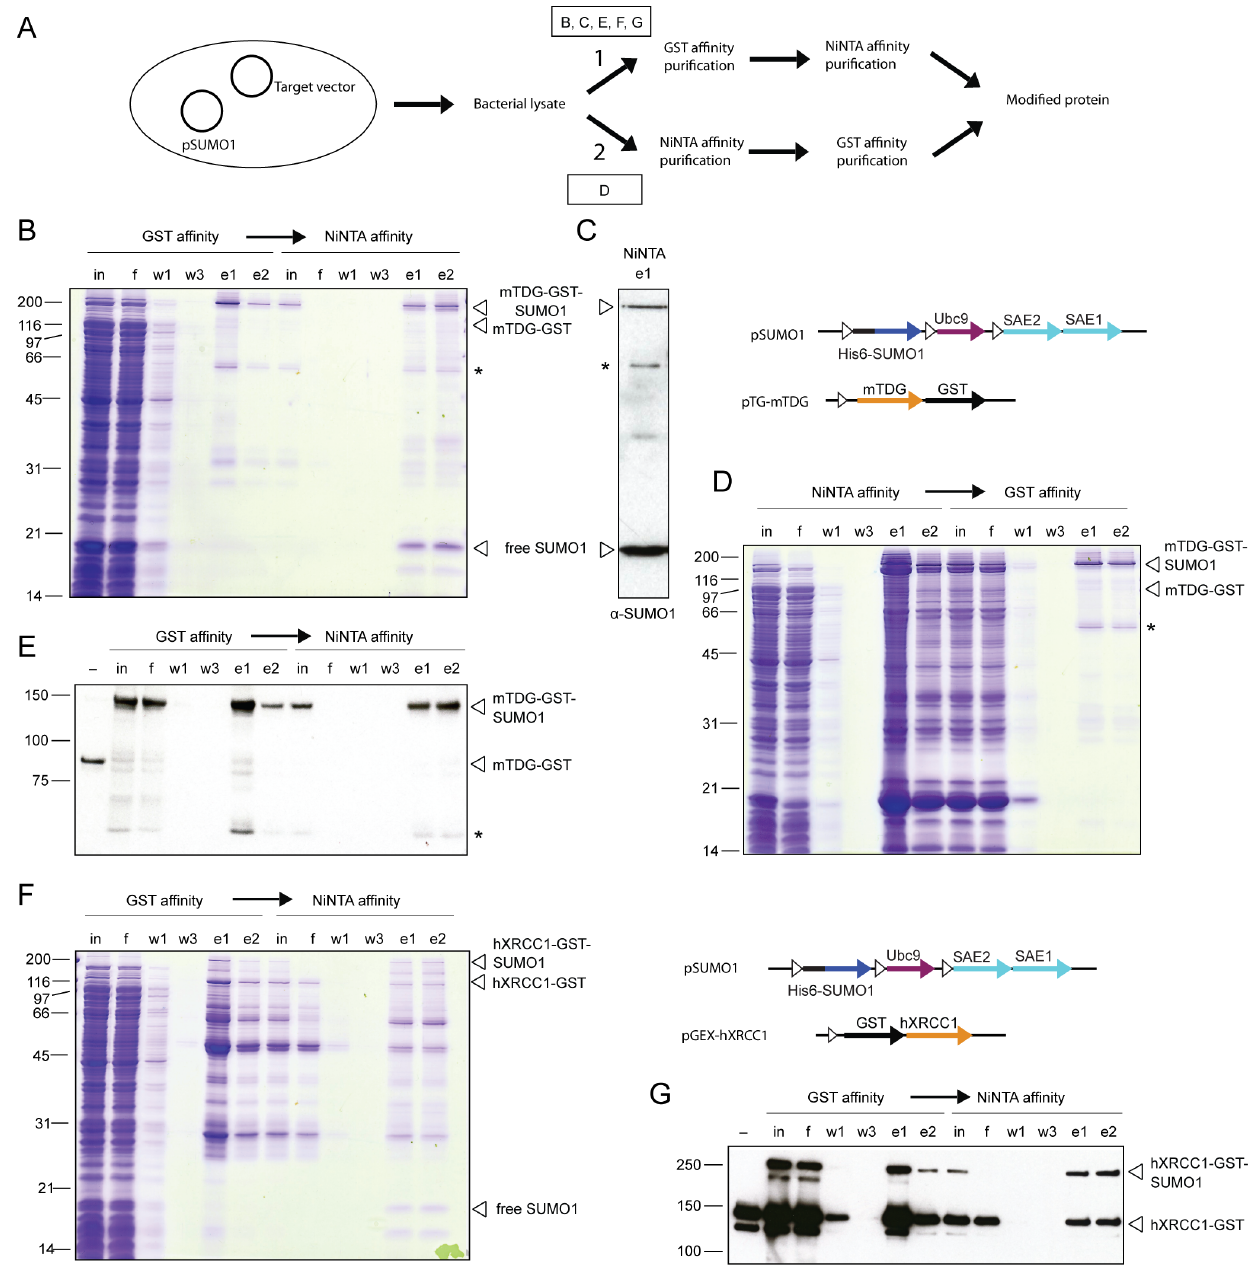
Figure 2. Purification of SUMO1-modified mTDG and hXRCC1 produced by in-cell SUMOylation. ( A ) Purification scheme for in-cell SUMO-modified protein. Cell lysates are subjected to subsequent GST- and Ni-NTA-affinity purification (work flow 1) or vice versa (work flow 2). Boxed letters indicate the corresponding sub-panels. Fractions of the purification of SUMO1-modified mTDG from purification work flow 1 ( B ) and 2 ( D ) and hXRCC1 from work flow 1 ( F ) were analyzed by SDS-PAGE and subsequent Coomassie blue staining and immunoblotting using monoclonal anti- GMP1 ( C ), polyclonal anti-mTDG ( E ) and anti-hXRCC1 ( G ) antibodies, respectively. in, input (cleared lysate or dialyzed elution fractions); f, flow through; w, wash steps; e, elution fractions; *, SUMO1-modified truncated mTDG.